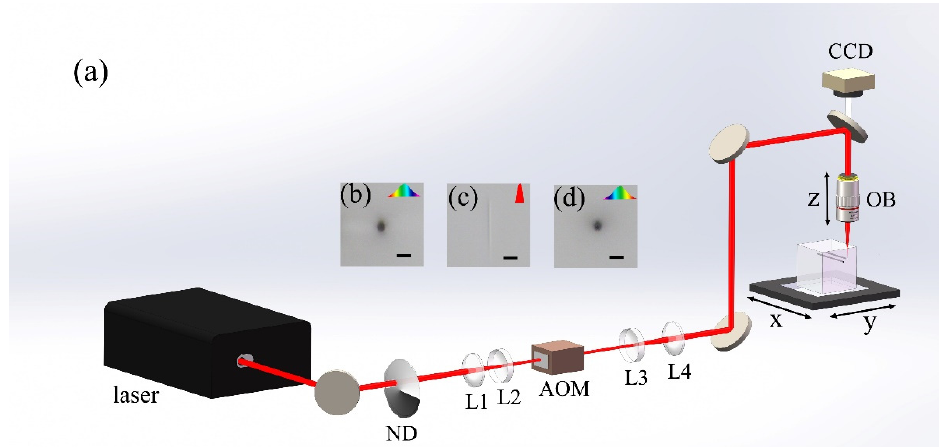
Figure 1. ( a ) Schematic of the experimental setup. ND, variable neutral density filter; L1 and L4, convex lens; L2 and L3, concave lens; AOM, acousto-optical modulators; CCD, charge-coupled device; OB, objective lens. Cross-sectional view of optical micrographs of lines inscribed in fused silica with ( b ) positively chirped 10 ps laser pulses, ( c ) transform-limited 190 fs laser pulses, and ( d ) negatively chirped 10 ps laser pulses. Scale bar: 25 μ m.